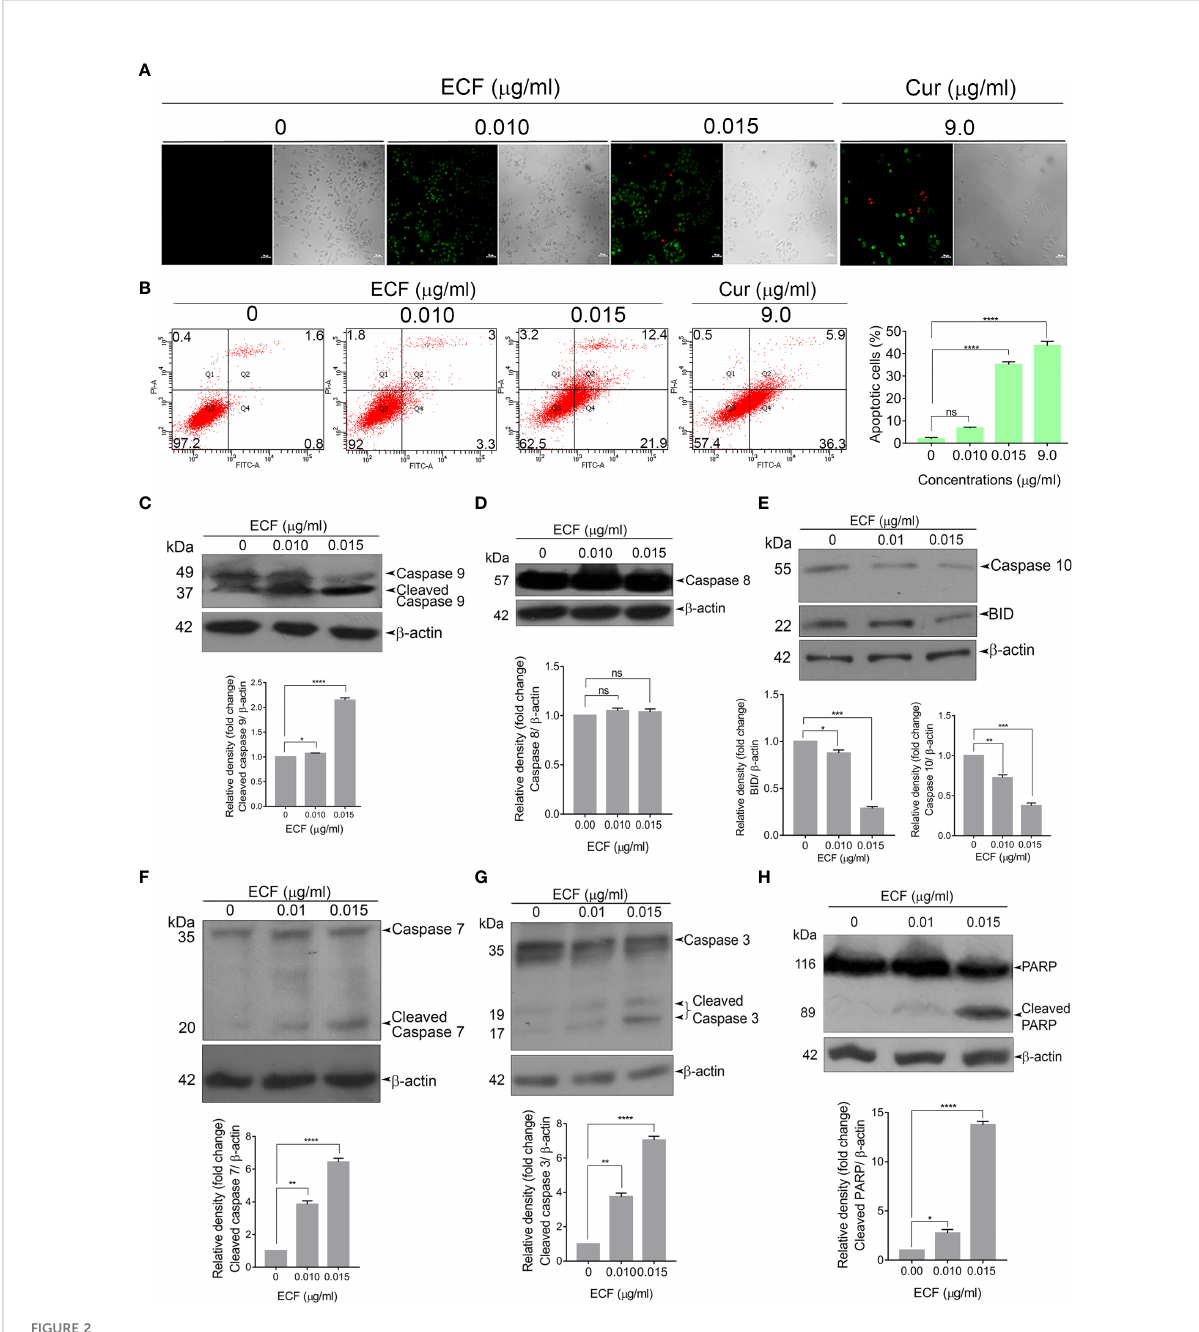
FIGURE 2 ECF triggers apoptotic mode of cell death in melanoma (A, B) ECF induces apoptosis in A375 cells as assessed by Annexin/PI staining, and was quantitated by FACS analysis. (C – H) ECF potentiates the activation of caspases and cleavage of PARP in A375 cells as analyzed by immunoblotting. Data are representative of three independent experiments (Mean ± SEM) and P-values are calculated using one-way ANOVA. ****P ≤ 0.0001, ***P ≤ 0.001, **P ≤ 0.01, *P ≤ 0.1and ns ≥